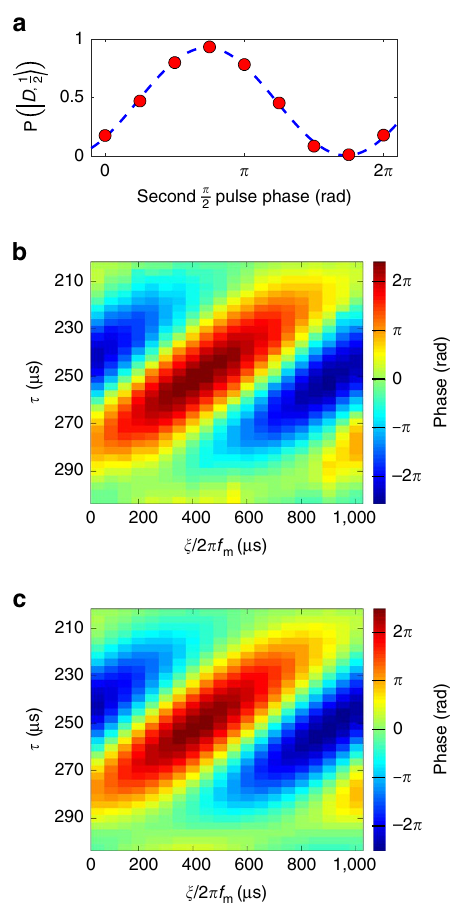
Figure 3 | Experimental results of quantum lock-in force measurement. ( a ) A typical measured Ramsey fringe (red full circles) and fit to theory (dashed blue line) from which the superposition phase is estimated. ( b ) Measured phase as a function of t and x . Each point on the plot corresponds to the phase extracted from a measurement similar to a . The phase offset x is affected by different technical delays in our system. ( c ) Theoretical calculation for b using equation (5) with A ¼ 2 p x 0 ffiffi fitted from b . The calculated value for the phase amplitude is A ¼ 0.774 ± 0.004rad, corresponding to x 0 ¼ 117.5 ± 0.5nm and F 0 ¼ 8.64 ± 0.03 (cid:2) 10 (cid:3) 19 N. projection noise. Using equation (1), we inferred a force magnitude of F 0 ¼ 8.64 ± 0.03 (cid:2) 10 (cid:3) 19 N. With a total experi- ment time of roughly 9 h, our force estimation uncertainty is 3 (cid:2) 10 (cid:3) 21 N, leading to sensitivity of 5.3 (cid:2) 10 (cid:3) 19 NHz (cid:3) 1/2 . uncertainty of 6 (cid:2) 10 (cid:3) 21 N, for an experiment time of roughly